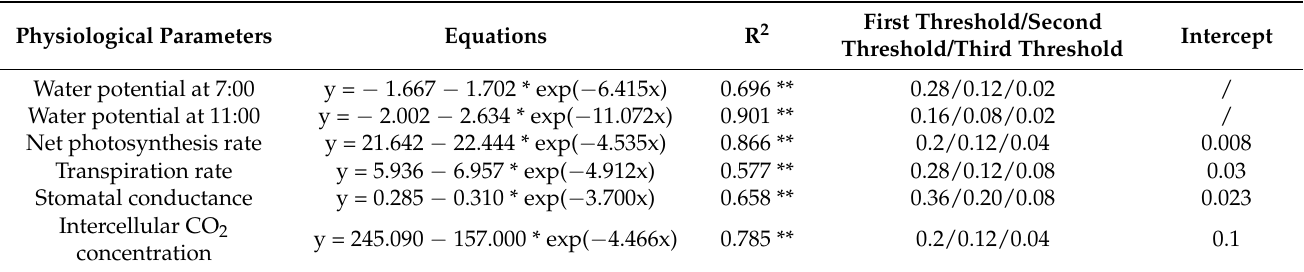
Table 1. Relationship between the water content and physiological indices for spring wheat and their thresholds.